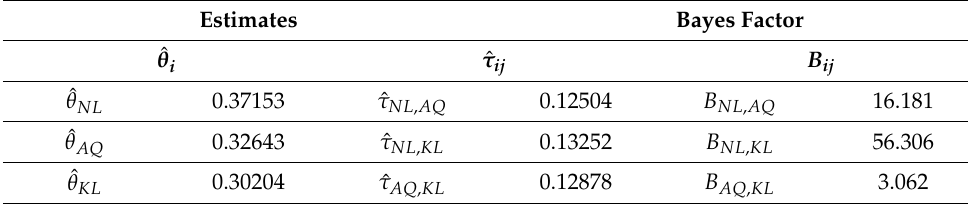
Table 7. Summaries of the analysis of the drinking water choice data.